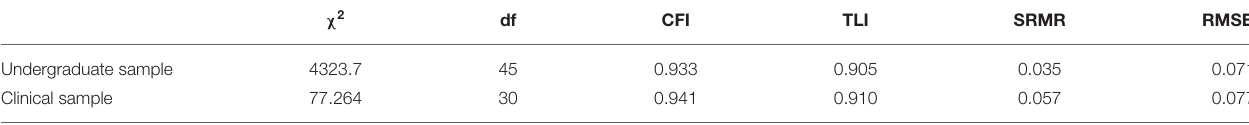
TABLE 4 | Goodness of fit indexes for the two-factor model of the